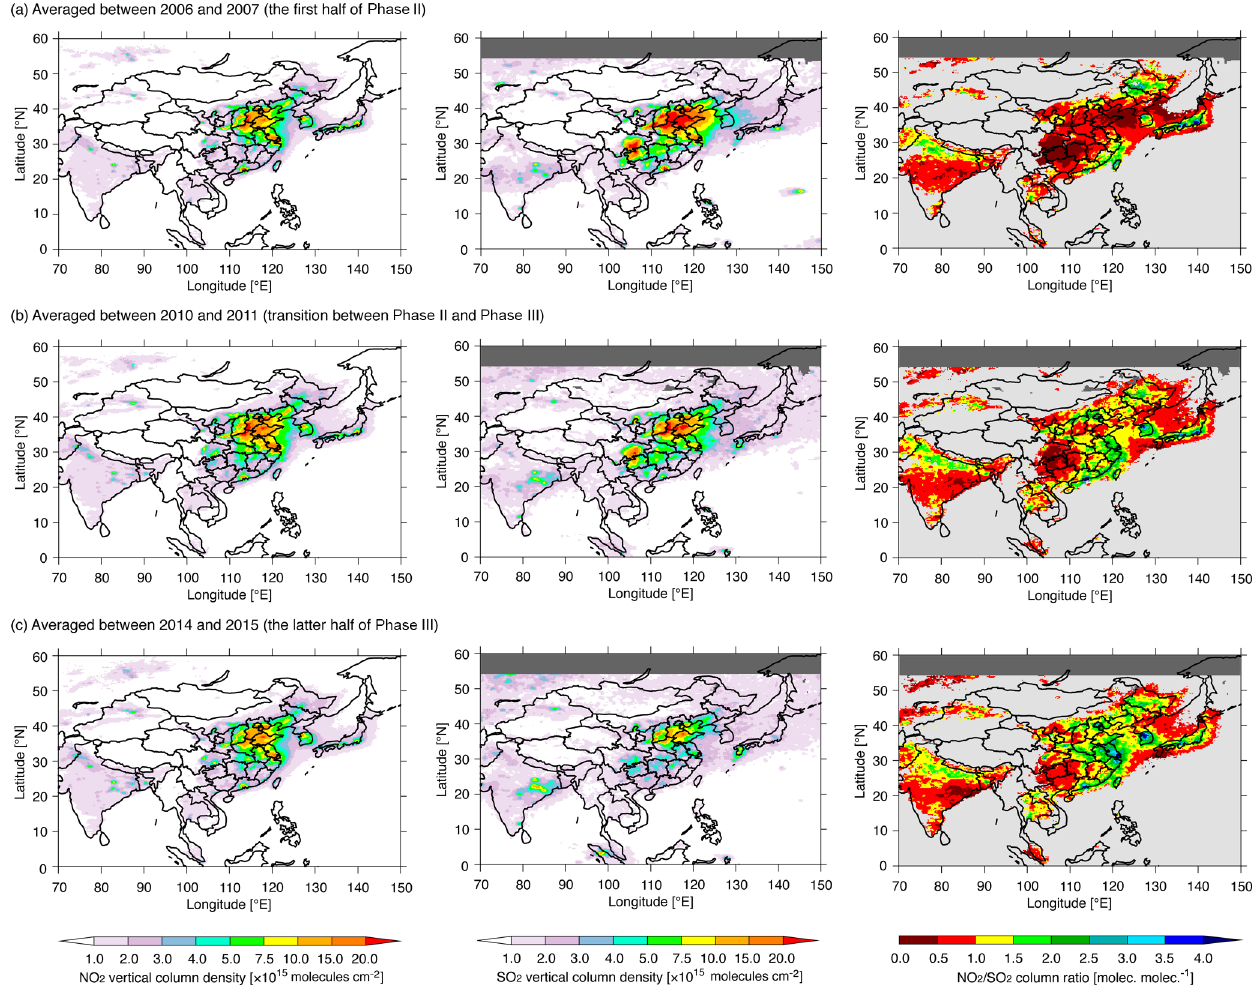
Figure 3. Satellite observations of the (left) NO 2 column, (center) SO 2 column, and (right) NO 2 / SO 2 column ratio averaged over (a) 2006–2007 (the first half of Phase II), (b) 2010–2011 (transition between Phase II and Phase III), and (c) 2014–2015 (the latter half of Phase III). Dark-gray cells indicate places where annual mean could not be calculated. If either the NO 2 or SO 2 column value is less than 1.0 × 10 15 moleculescm − 2 , this is indicated by a light-gray cell to clarify the NO 2 / SO 2 column